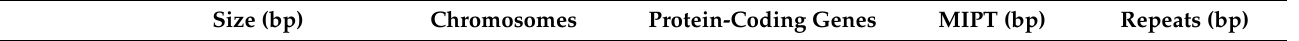
Table 1. General genome features of the assembled C. lancifolium and C. macrorhizon mitogenomes.